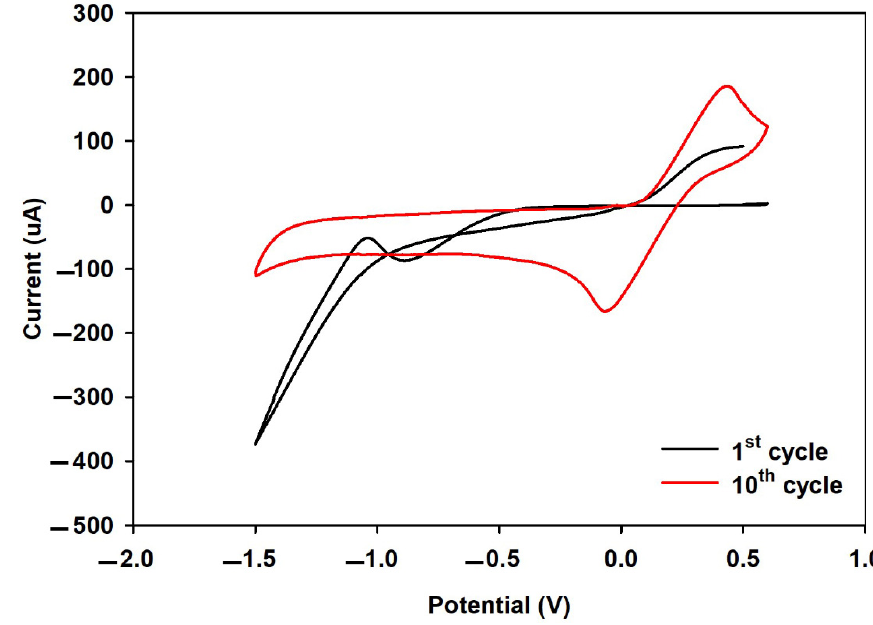
Figure A2. The voltammograms of the CV cycles used to electrochemically reduce GO.